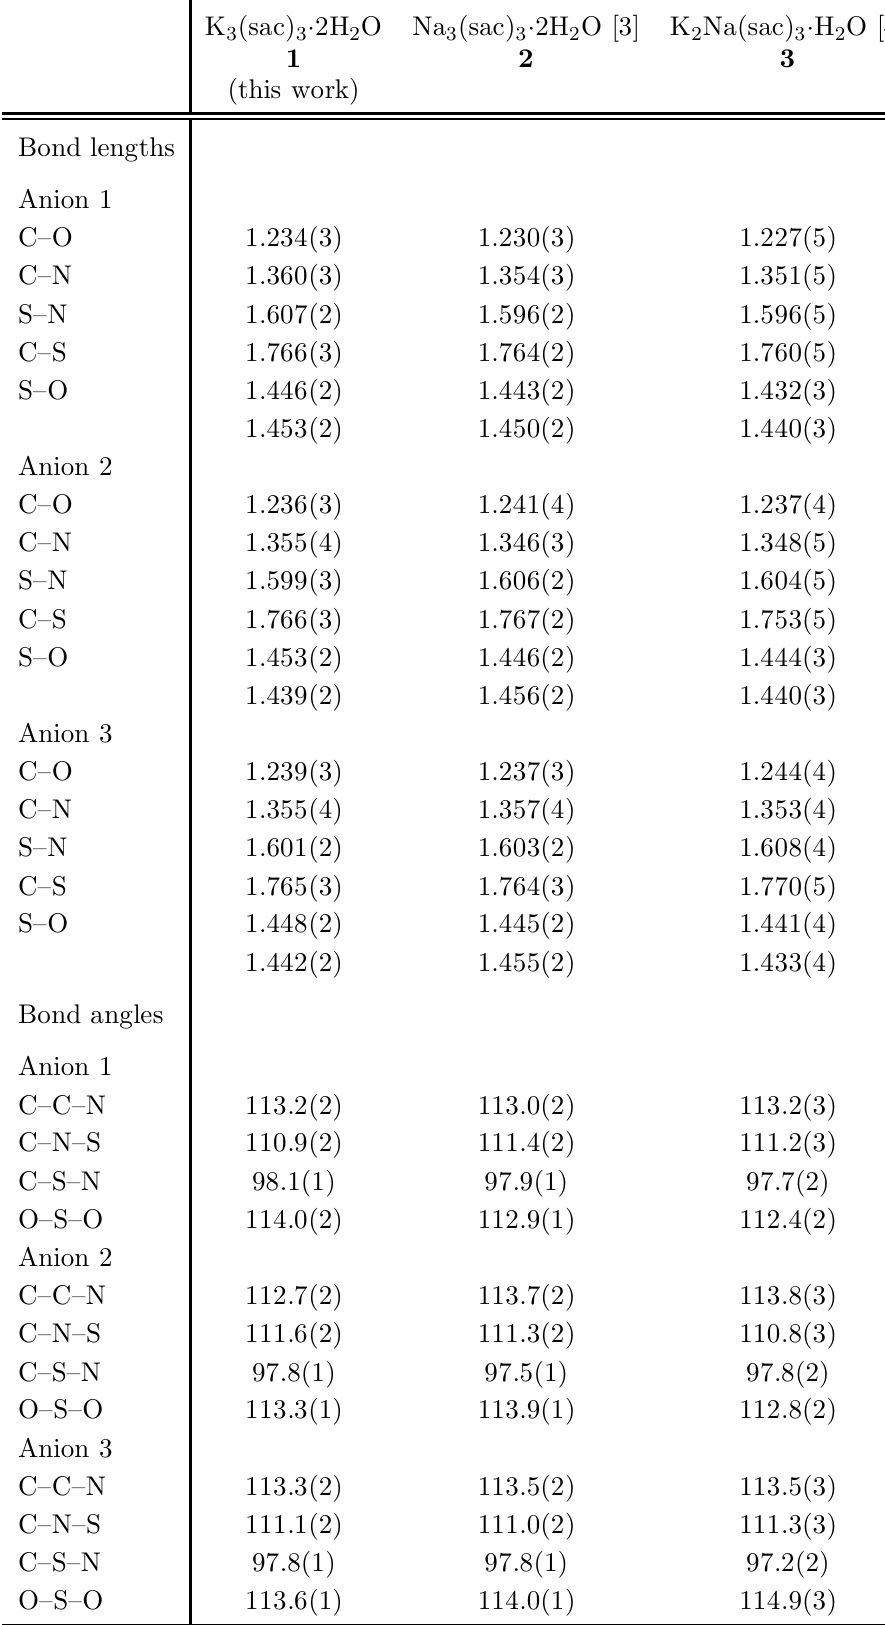
Table 3 Selected bond lengths (¸A) and angles ( o ) in the saccharinato ions for K 3 (sac) 3 ¢ 2H 2